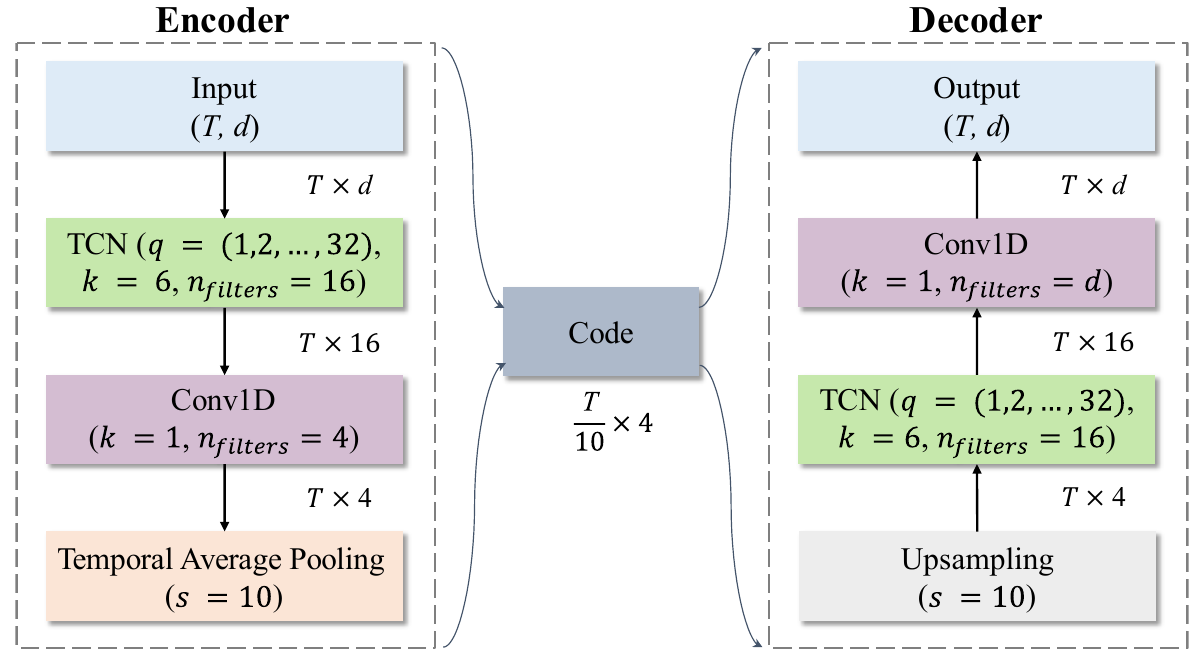
Figure 8. Our proposed TCN-AE model.